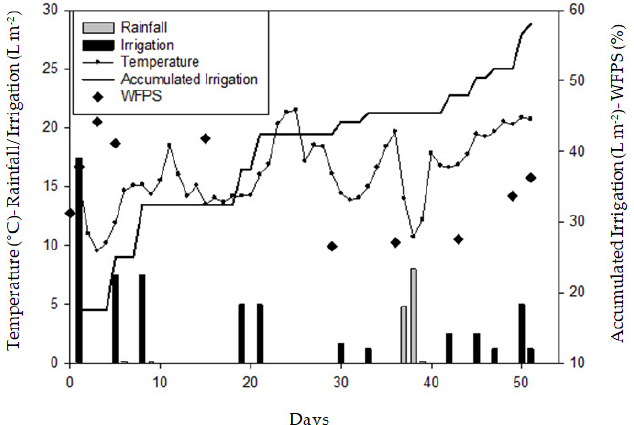
Figure 1. Mean temperature (°C), WFPS: water-filled pore space (%), rainfall (L m −2 ), daily irrigation (L m −2 ), and accumulated irrigation (L m −2 ) at the experimental site.